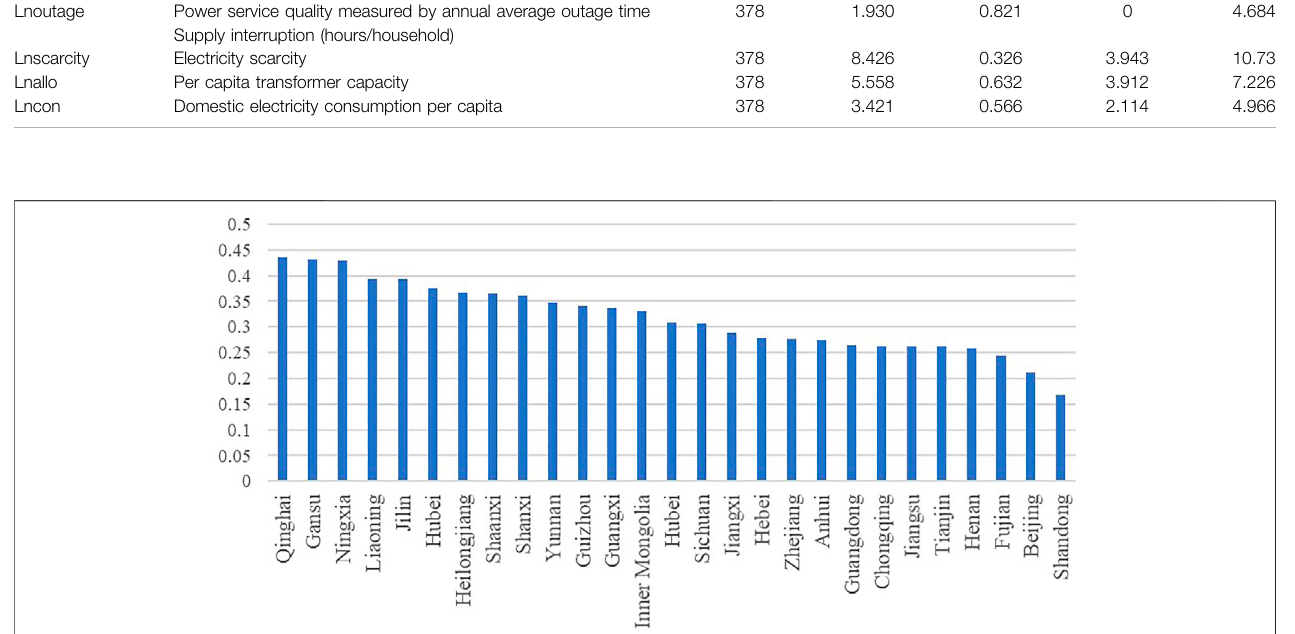
FIGURE 1 | Average values of grid market power.